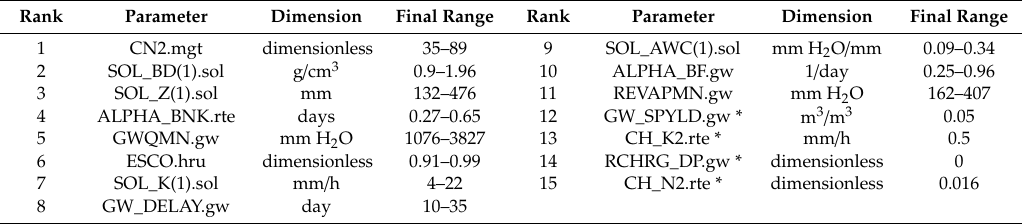
Table 2. Ranked most sensitive SWAT-parameters with final calibrated range for the di ff erent